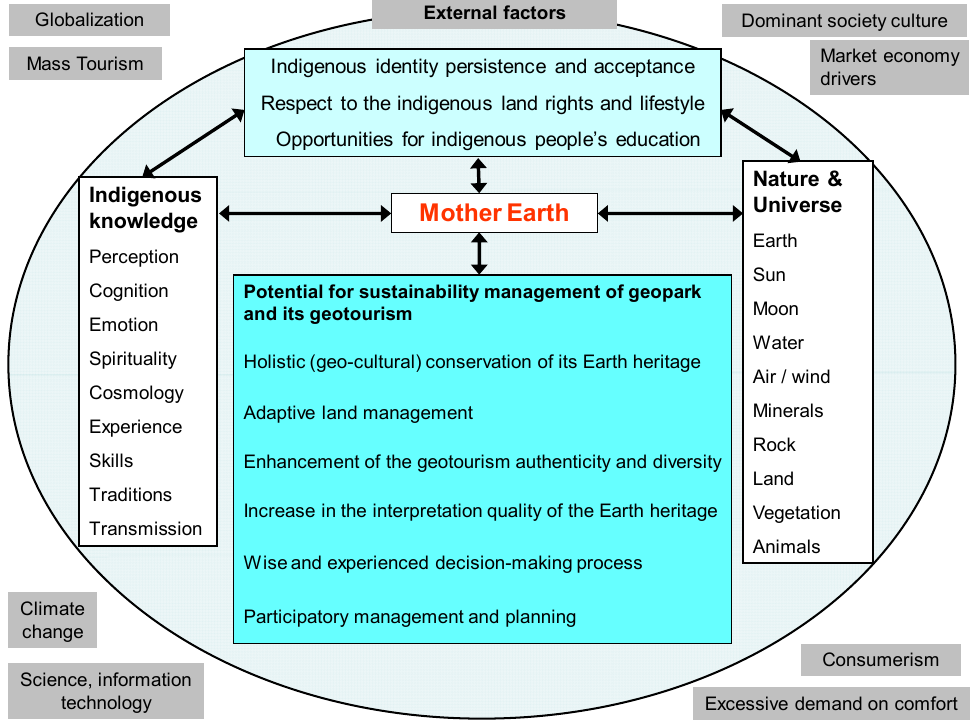
Figure 5. Model of indigenous knowledge potential for the geopark sustainability management.